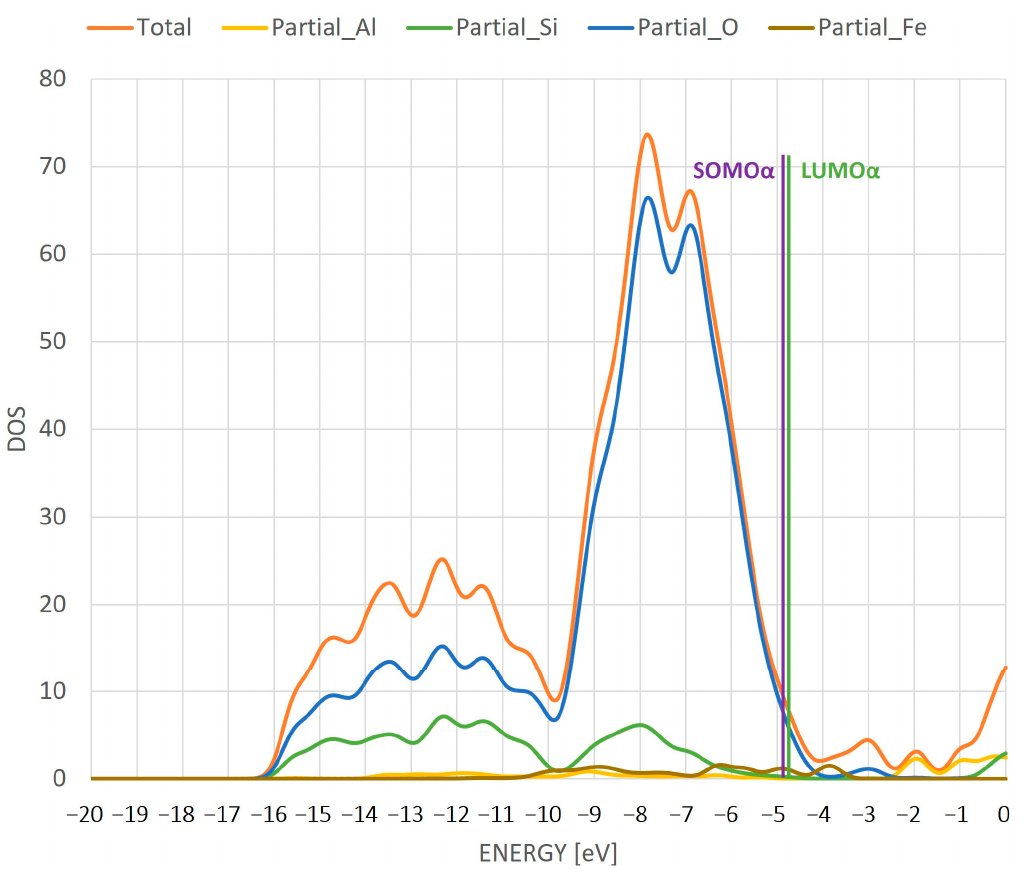
Figure 6. DOS diagram for individual atoms in the ZSM-5 structure with FeO adsorbed on the active site. The line in the diagram shows the position of SOMO and LUMO orbitals.